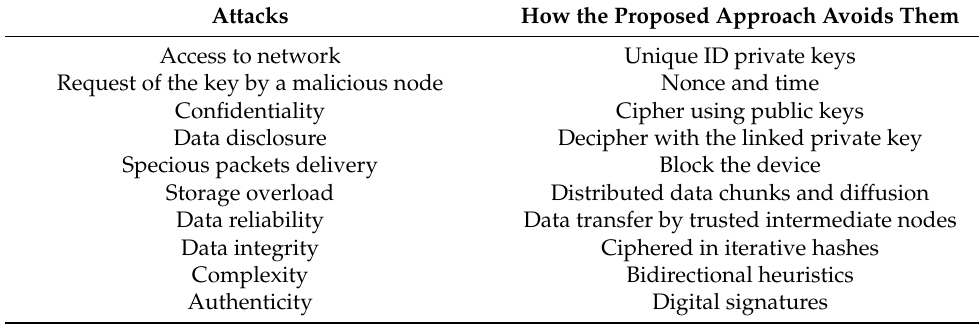
Table 2. Security analysis of our proposed approach.